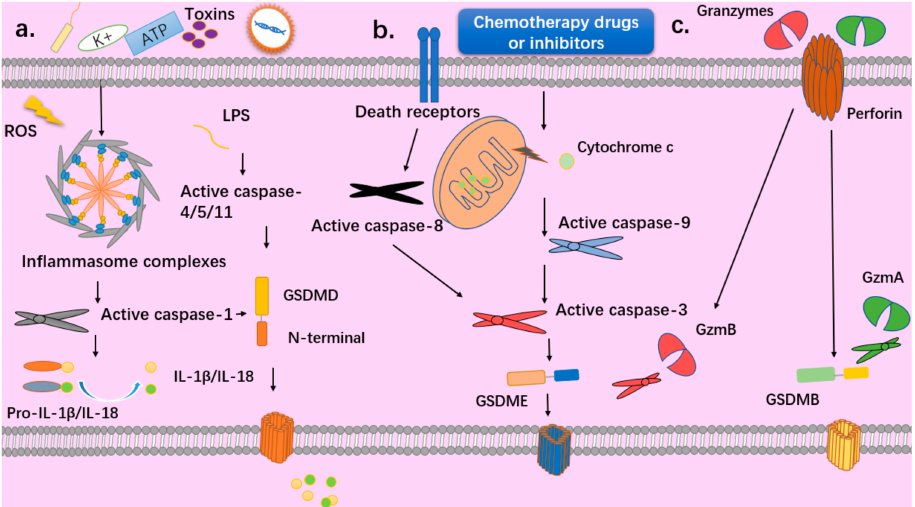
Figure 1. Different pathways to pyroptosis. ( a ) Canonical pyroptosis: PAMPs such as Gram-negative bacteria, viruses, toxins and DAMPs such as intracellular ROS, ATP, potassium, cadmium can activate the inflammasomes and activated caspase 1 can cleave GSDMD and pro-IL-1 β /IL-18. Non-canonical pyroptosis: Bacterial lipopolysaccharide (LPS) directly binds to and activates pro-caspase 4/5 or murine pro-caspase 11, then the activated caspases cleave GSDMD. ( b ) Chemotherapeutic drugs or inhibitors can disrupt the mitochondrial membrane and the release of cytochrome c activates caspase 9 and caspase 3 to cleave GSDME and trigger pyroptosis. Caspase 3 could also be activated by caspase 8 when death receptors are stimulated. ( c ) Cytotoxic T lymphocytes (CTLs) and natural killer (NK) cells release perforin to deliver serine protease granzymes (Gzms) into target cells, and then GzmA and GzmB can cleave GSDMB/E, which triggers